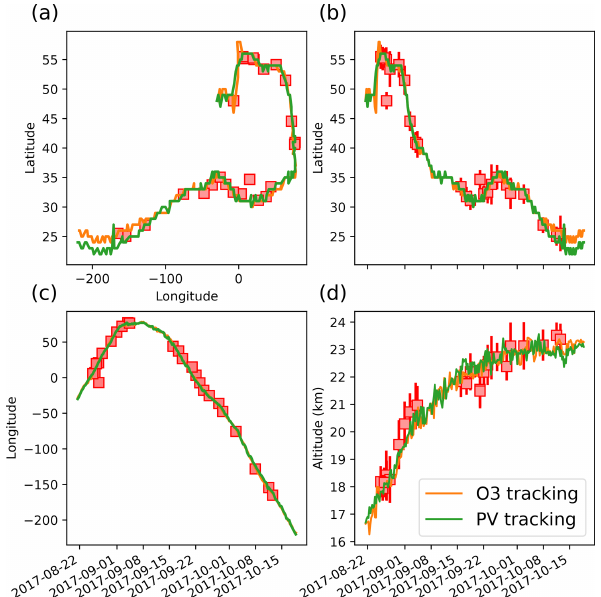
Figure 5. The trajectory of vortex A tracked from the ERA5 fields of PV (orange) and ozone (green): (a) the trajectory in the longitude–latitude plane; ( b–d ) latitude, longitude and altitude as a function of time respectively. The green curves mostly mask the or- ange curves as they almost exactly coincide. The boxes show the lo- cation of the smoke bubble according to CALIOP during CALIPSO overpasses, and the bars indicate the range of the bubble in latitude and